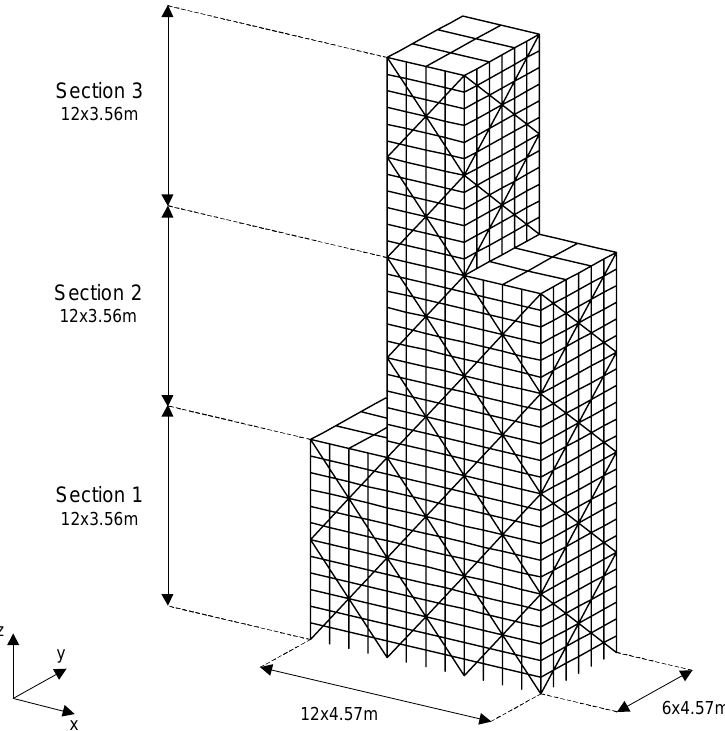
Figure 9. Test Problem 2: schematic of the 36-story steel space frame structure and definition of the three 12-story sections along its